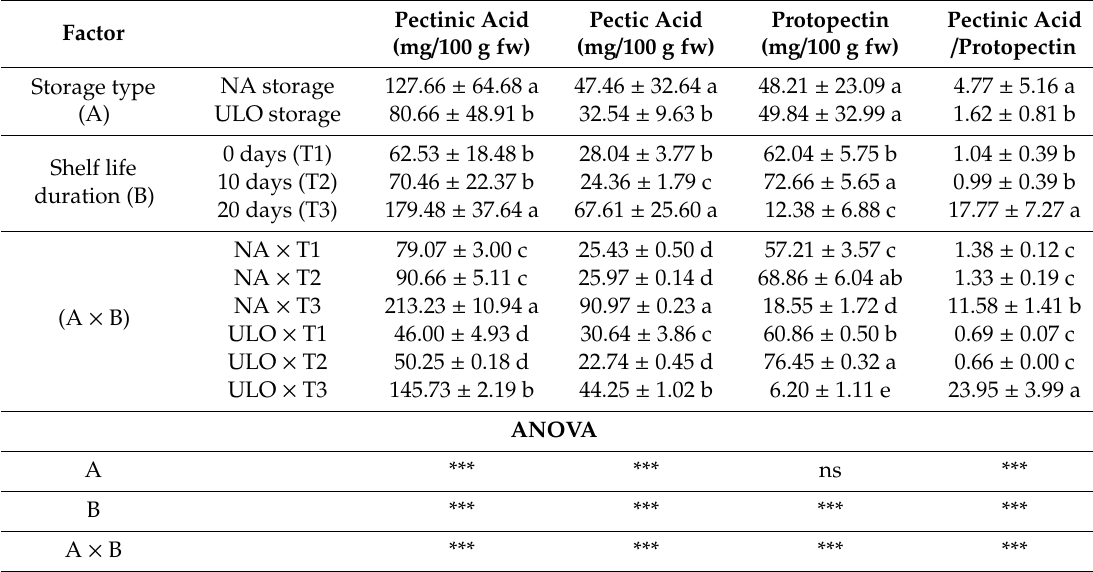
Table 4. The e ff ect of storage type and shelf life duration on the content of pectic fractions in ‘Idared’